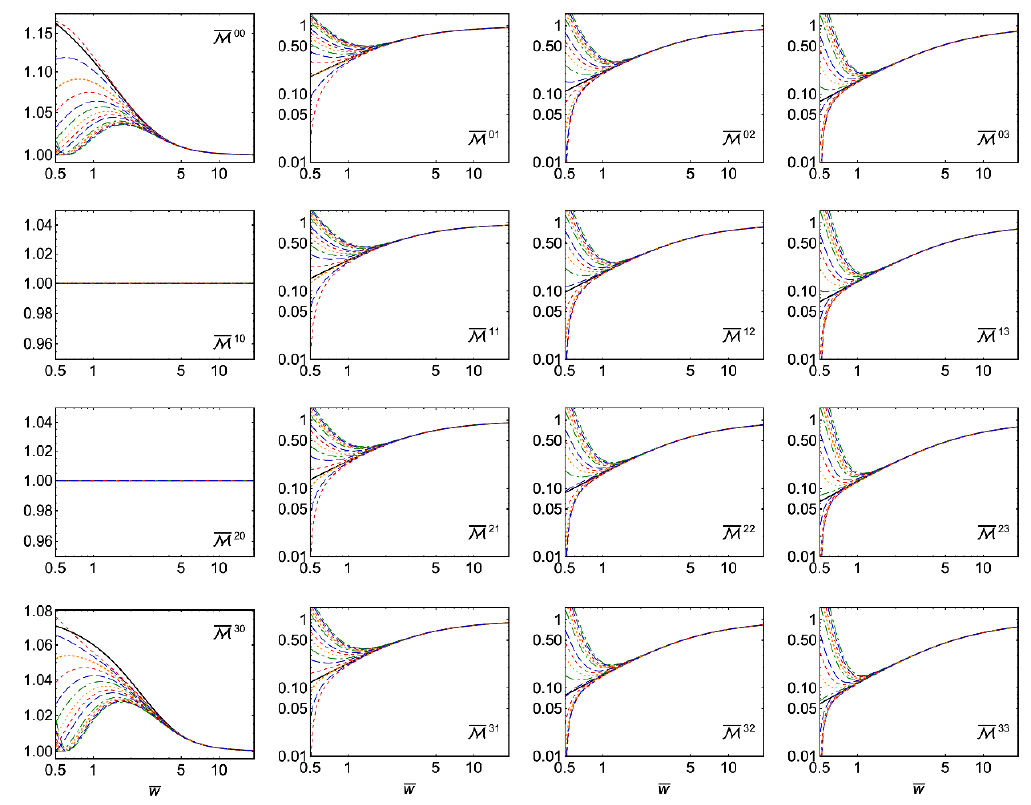
Figure 1 . The scaled moments M nm = M nm ( (cid:28) ) = M nm solution (solid black line) are compared to a set of exact solutions (various colored dotted and dashed lines) initialized with varying (cid:11) 0 . The horizontal axis is w (cid:17) (cid:28)=(cid:28) eq = (cid:28)T= 5(cid:22) (cid:17) . Panels show a grid in n and m